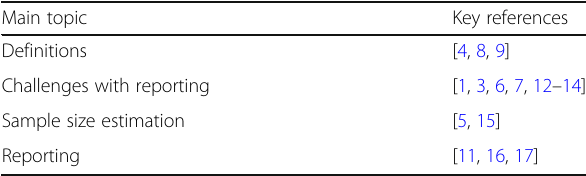
Table 1 Some key references about different topics related to pilot or feasibility